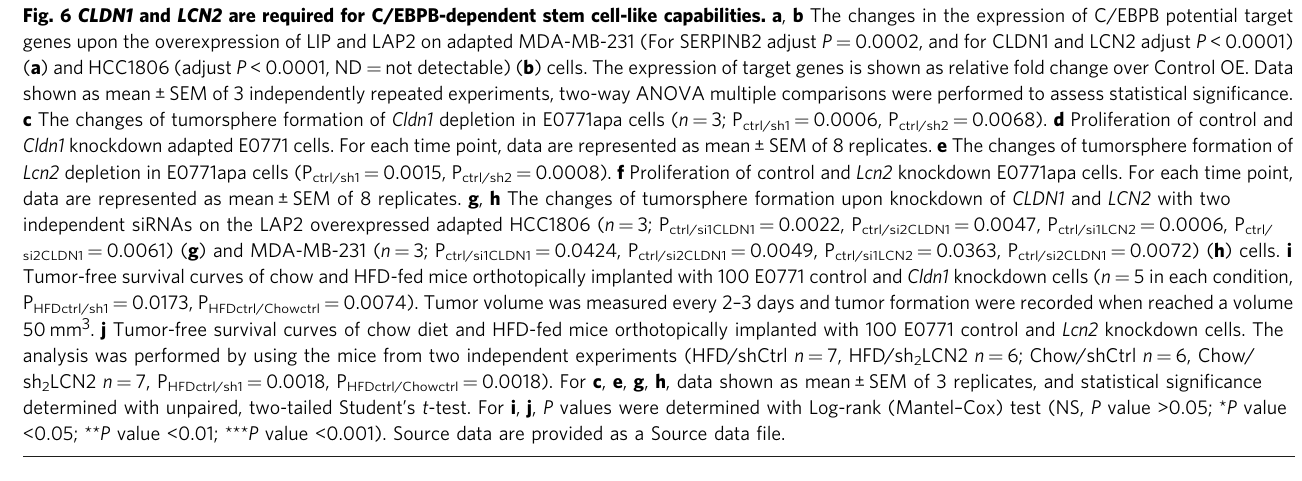
Fig. 6 CLDN1 and LCN2 are required for C/EBPB-dependent stem cell-like capabilities. a , b The changes in the expression of C/EBPB potential target genes upon the overexpression of LIP and LAP2 on adapted MDA-MB-231 (For SERPINB2 adjust P = 0.0002, and for CLDN1 and LCN2 adjust P < 0.0001) ( a ) and HCC1806 (adjust P < 0.0001, ND = not detectable) ( b ) cells. The expression of target genes is shown as relative fold change over Control OE. Data shown as mean ± SEM of 3 independently repeated experiments, two-way ANOVA multiple comparisons were performed to assess statistical signi fi cance.